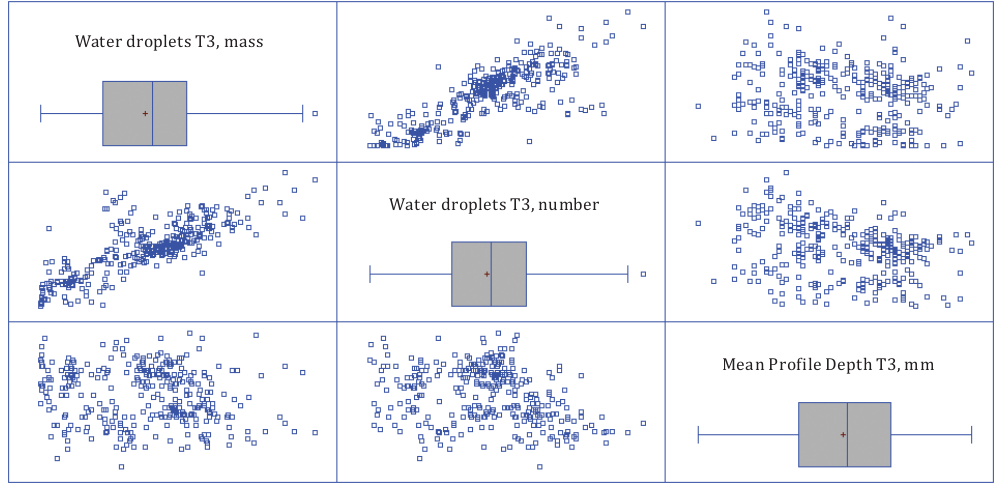
Figure 13. Scatterplot matrix of Road Section 3